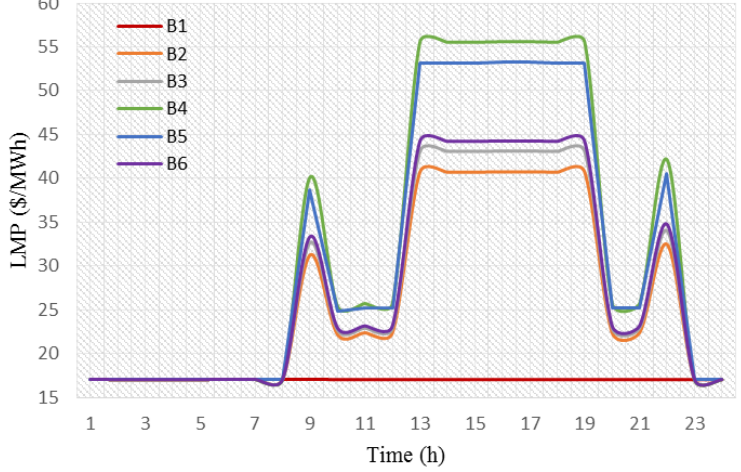
Figure 4. The locational marginal pricing (LMP) curves for different buses in the 6-bus system.